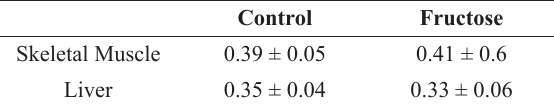
Glycogen content in skeletal muscle and liver of animals 24 hours after fructose administration.